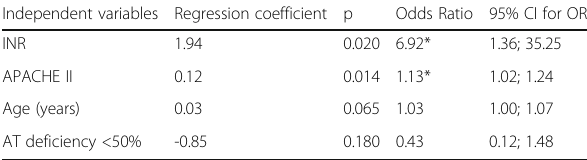
Table 2 (abstract 000156). Variables, predicting outcome at the 30th day Independent variables Regression coefficient